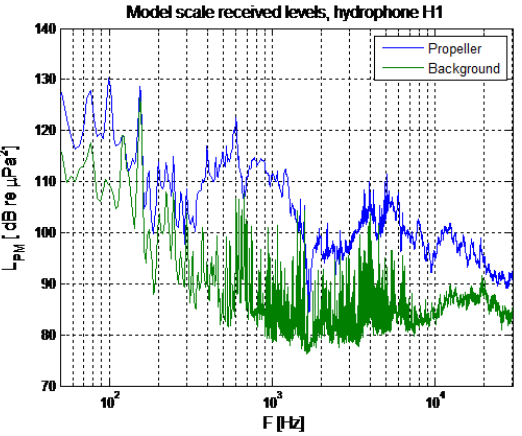
Figure 17: Cavitation tunnel received levels, hydrophone H1.